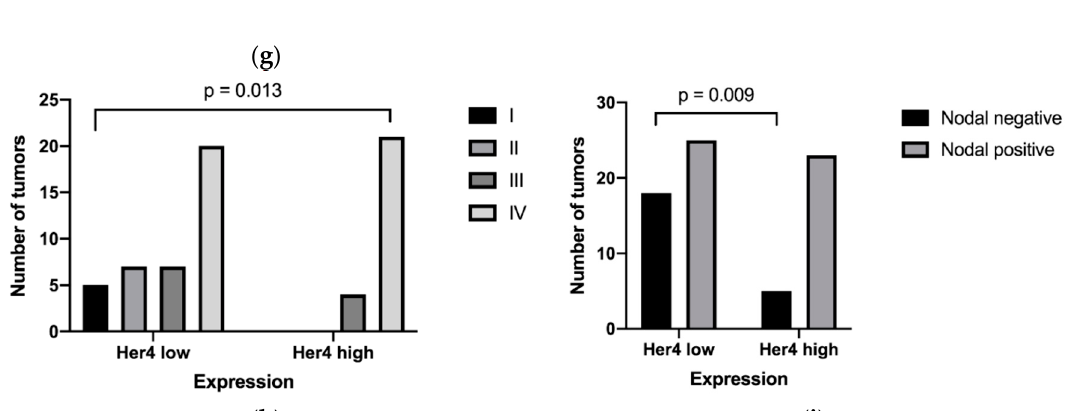
Figure 2. Expression distribution of growth factor receptors in relation to the clinical features: ( a ) EGFR and p16 expression; ( b ) EGFR expression and T category; ( c ) Her2 expression and pack years; ( d ) Her4 expression and tumor site; ( e ) c-Met and p16 expression; ( f ) c-Met expression and pack years; ( g ) c-Met expression and T category; ( h ) Her4 Expression and tumor stage; and ( i ) Her4 expression and nodal positivity. ( a , c , e , f ) Box plots with whiskers showing median, quartiles, maximum and minimum; ( b , g ) column bar graphs showing mean with standard deviation; ( d ) column bar graph showing before and after values; and ( h , i ) interleaved bars comparing absolute values.